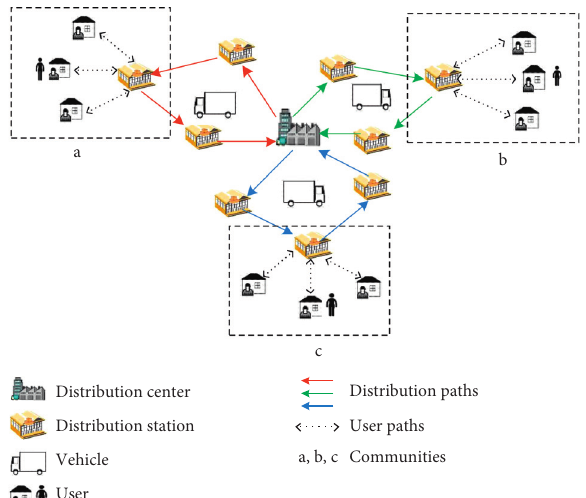
Figure 1: The schematic diagram of the urban regional logistics distribution